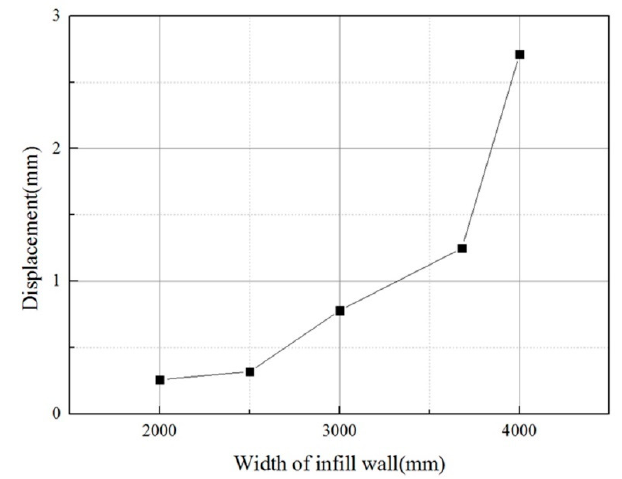
Figure 13. Variation curve of the horizontal displacement at the initial cracking of the interface with the width of infill wall.